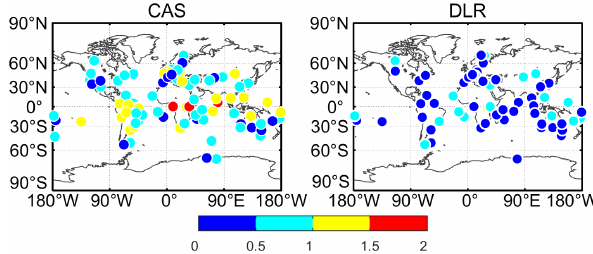
Figure 5. The rms of estimated receiver DCB with respect to CAS and DLR.